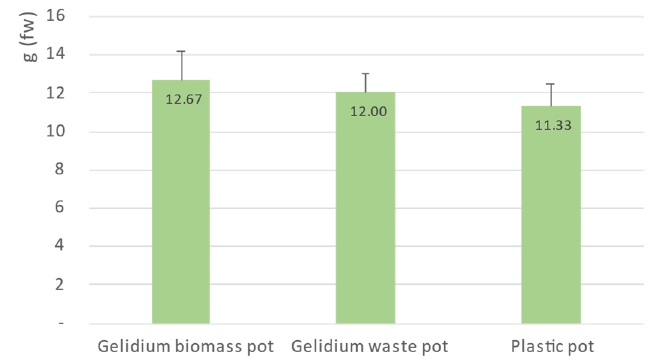
Figure 8. Fresh weight (in g) of Lactuca sativa (lettuce) grown in pots made with Gelidium biomass fibres, Gelidium waste fibres, and plastic pots, for 22 days (n = 3).